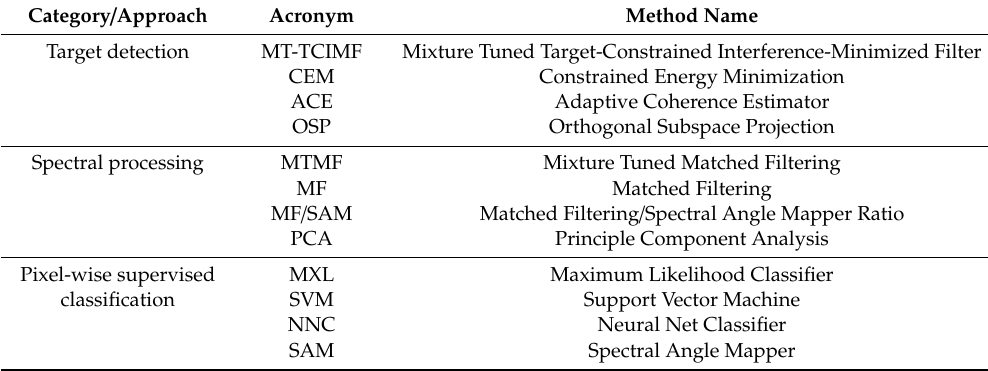
Table 3. Target detection, spectral processing and pixel-wise supervised classification approaches and their relevant methods along with their acronyms used in present